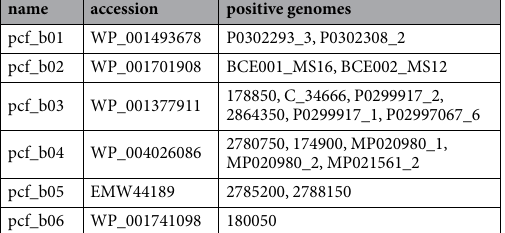
Table 3. Six Novel Colonization Factor Gene Clusters Identified and Prevalence in